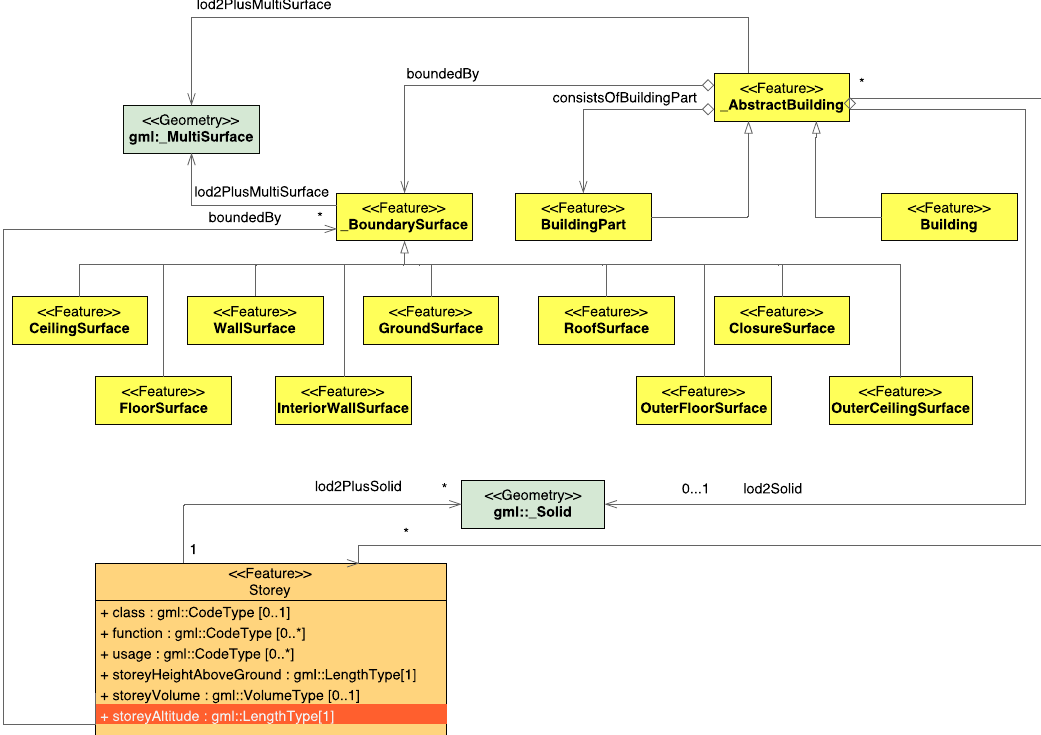
Figure 11. The proposed level of detail two plus (LoD2+) model, which carries information about the number of stores as proposed by [11] and their corresponding